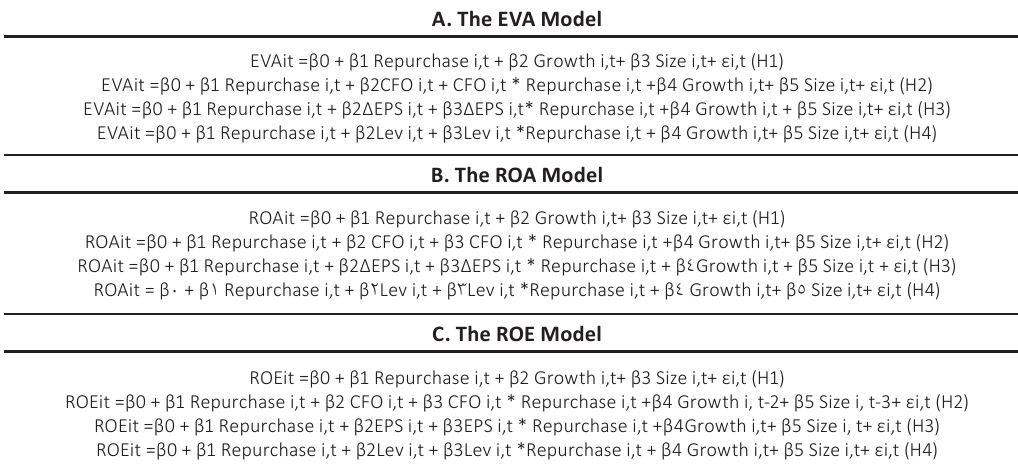
Figure 1. Research